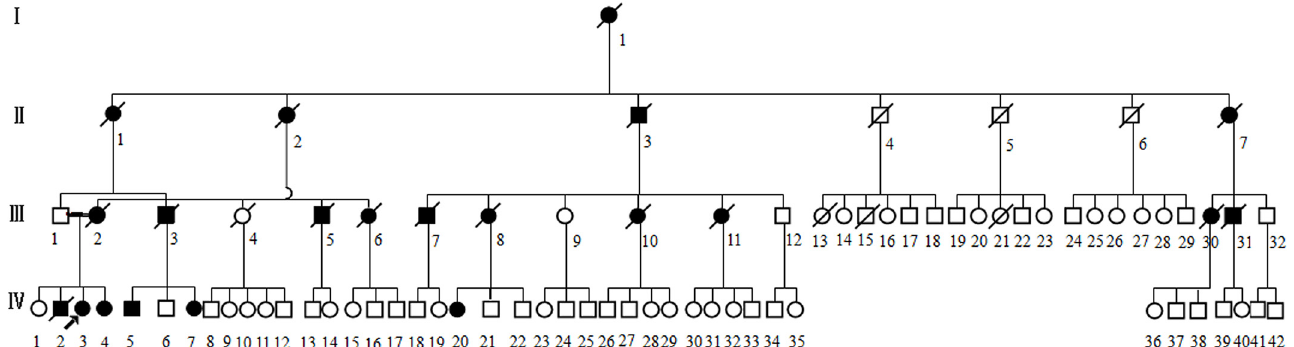
Fig 1. Pedigree of the family. Squares represent male family members; circles, female family members; filled symbols, affected subjects; a diagonal line through a symbol, deceased; short arrow, proband.